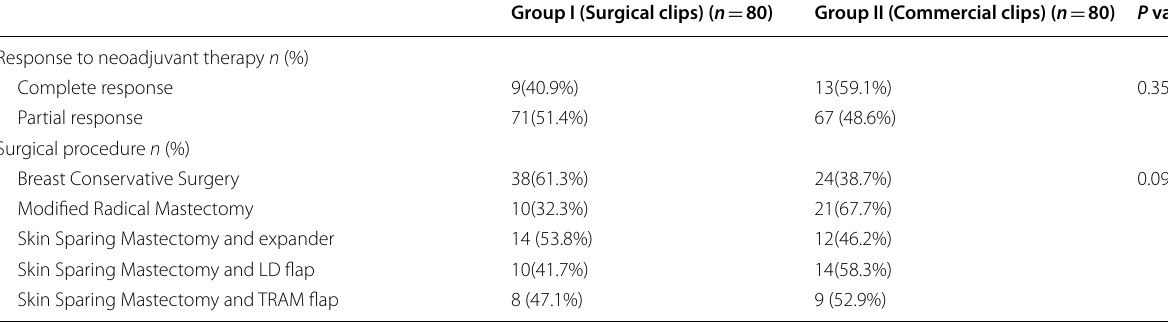
Group I (Surgical clips) ( n 80) =